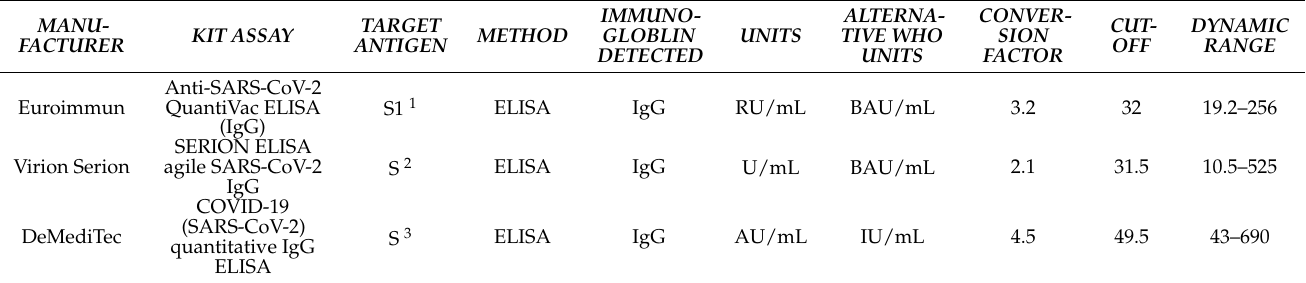
Table 1. General assays information provided by the